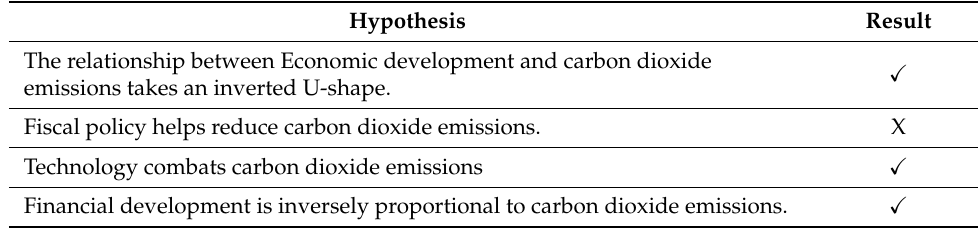
Table 7. Summary of hypothesis